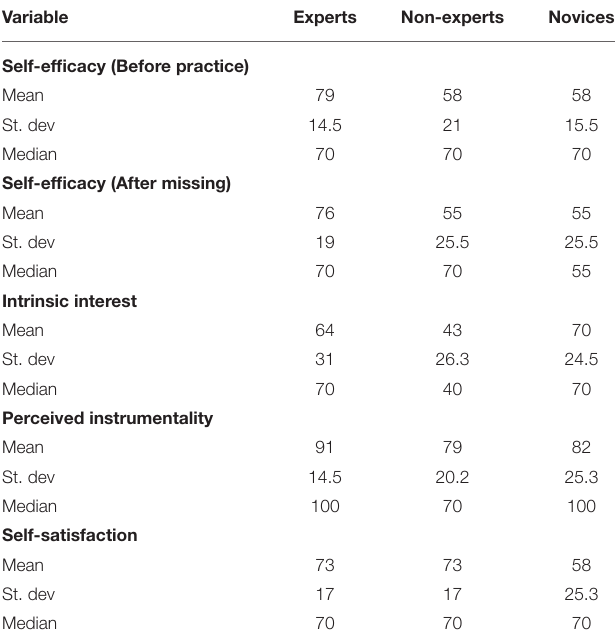
Table 6 . “Do Not Know” was never applied to the statements by the two